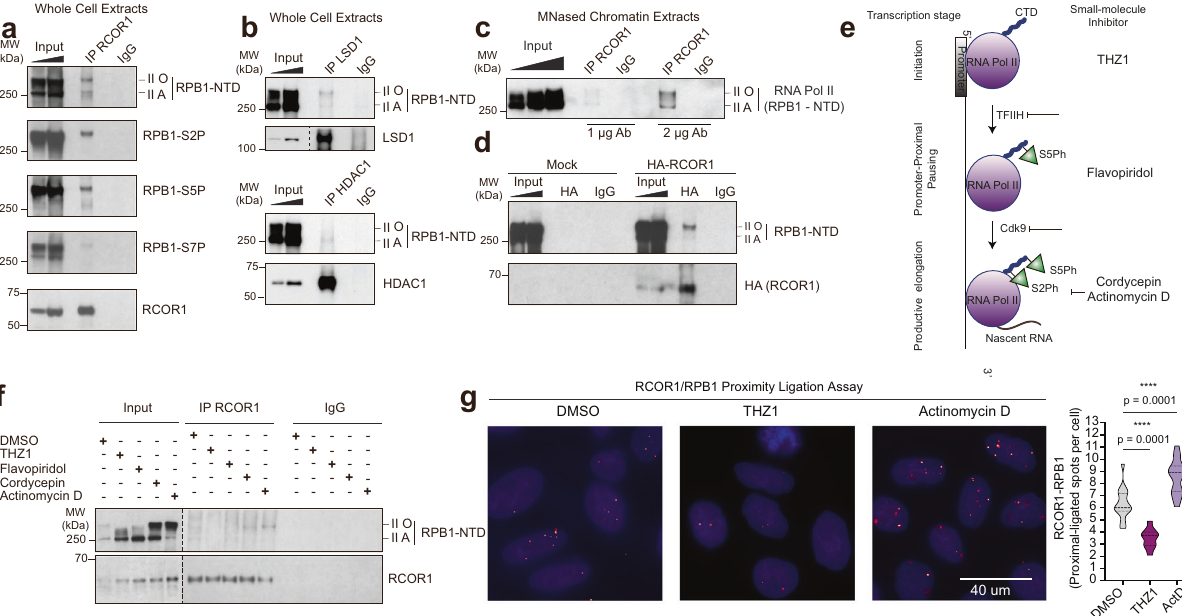
Fig. 5 RCOR1 establishes an interaction with RNA POL-II after initiation and before elongation. a Western blot analyses of immunoprecipitation of RCOR1 and co-precipitation of RPB1 and its phosphorylated isoforms from whole cell extracts. II-O: Hyperphosphorylated isoforms. II-A: Hypophosphorylated isoforms. RPB1-NTD CoIP panel is representative of four independent experiments while others are representative of two independent experiments. b Western blot analyses of immunoprecipitation of LSD1 (top) or HDAC1 (bottom) and co-precipitation of RPB1. Experiment performed once. c Western blot analysis of immunoprecipitation of RCOR1 and RNA POL-II from MNased chromatin using 2 different RCOR1 antibody concentrations. Panels are representative of two independent experiments. d HA-Pulldown on extracts derived from empty-vector and HA-RCOR1 overexpressing HEK293 cells. Panels are representative of two independent experiments. e Scheme depicting different stages of eukaryotic RNA POL-II transcription. It highlights the steps that are inhibited by THZ1, Flavopiridol, Cordycepin, and Actinomycin D. CTD: Carboxy-terminal domain. S5Ph: Phosphorylated serine 5. S2Ph: Phosphorylated serine 2. f Western blot analyses of RCOR1 immunoprecipitation and RPB1 co-precipitation under inhibition of transcription at different steps. Panels are representative of three independent experiments. g Proximity ligation assay between RCOR1 and RPB1 under DMSO, THZ1 and Actinomycin D treatments in HT22 cells. Right graph shows the distribution of proximal-ligated spots per cell under each treatment. More than 128 cells from three independent experiments were analyzed per treatment. Statistical signi fi cance was checked on Graphpad Prism by con fi rming normal distribution of data by D ’ Agostino & Pearson, Shapiro-Wilk and KS normality tests. Data was subjected to an ordinary, unpaired, one-way ANOVA test with 99% con fi dence intervals, **** means p < 0.01. Source data are provided as a Source Data fi